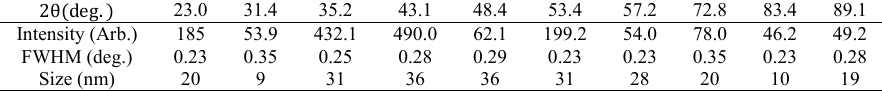
Figure 2 . XRD pattern of (Up): GO/ C 2 S composite and (Down): dicalcium silicate synthesized by Pechini method